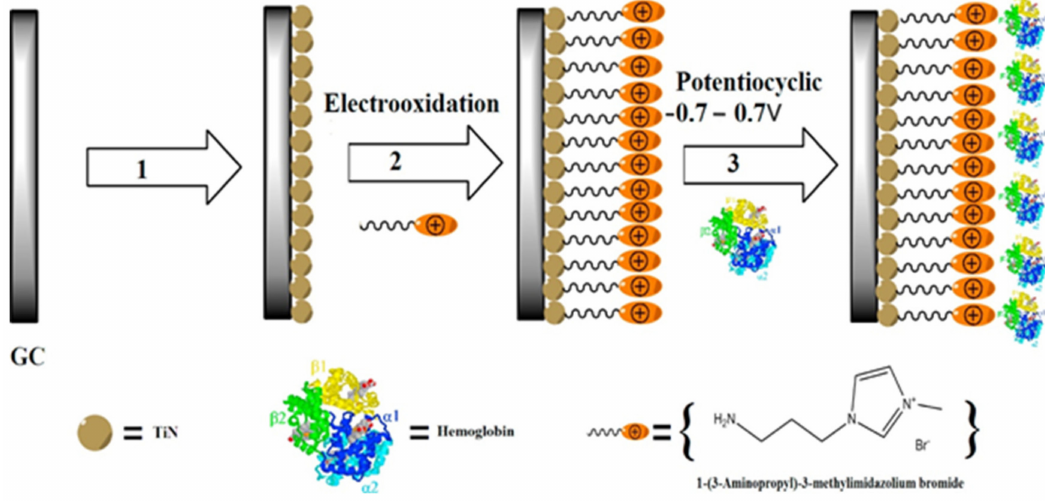
Figure 3. Schematic illustration of the fabrication process of GC/TiNnp/NH 2 − IL/Hb